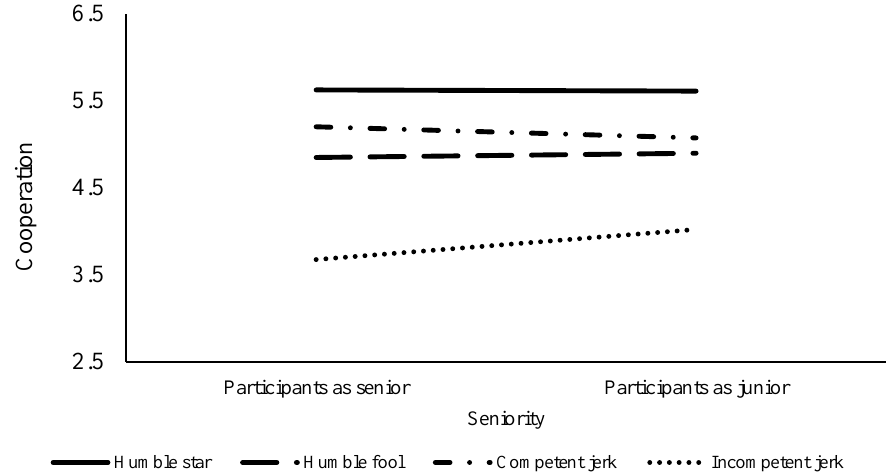
Figure 3. The Moderating Effect of Seniority on the Effects of the Four Archetypes on Cooperation.